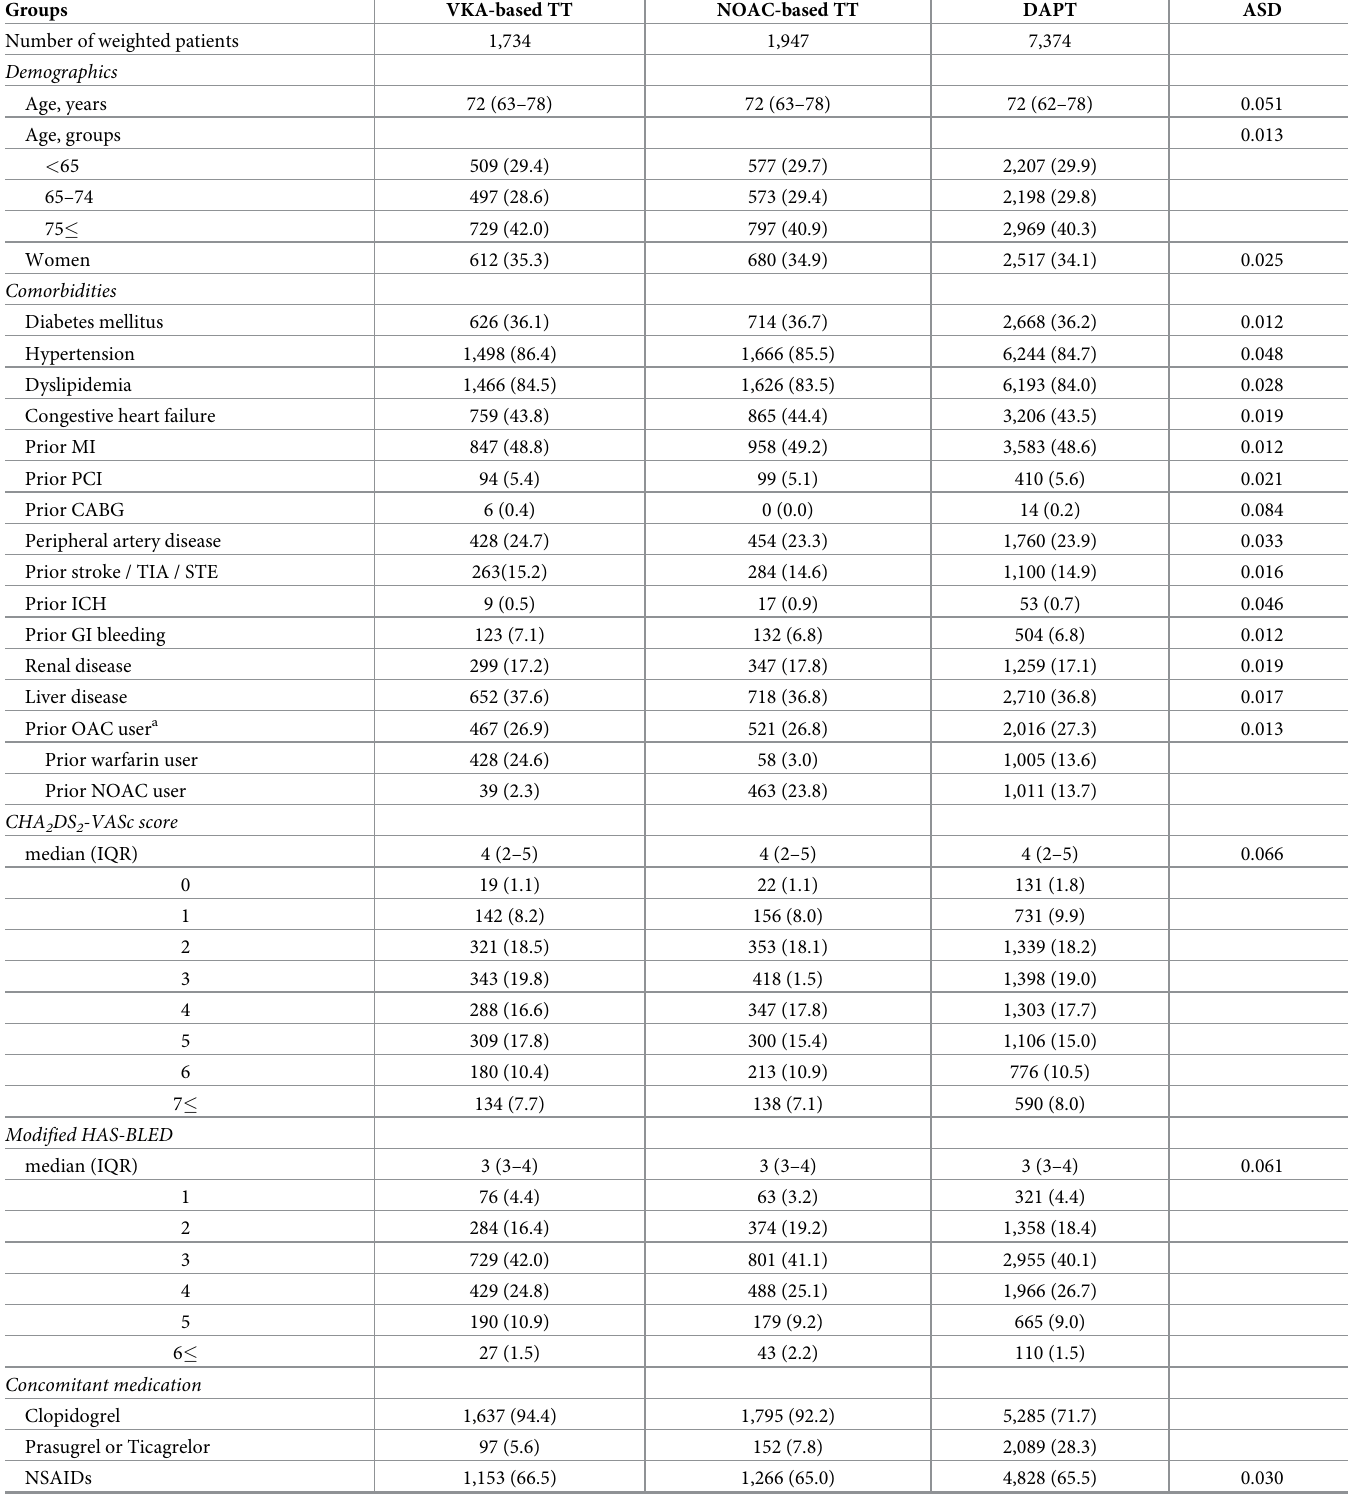
Table 1. Baseline characteristics of IPW